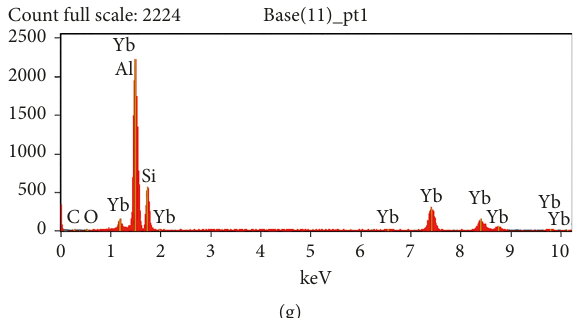
Figure 8: SEM-EDS image of Yb-rich intermetallic compounds in Al-7 wt.% Si alloy with 0.05 wt.% Sr and 0.7 wt.% Yb. (a) SEM image of Yb-rich intermetallic compound; (b) Al, (c) Si, (d) Fe, (e) Yb, (f) Sr, and (g) EDS spectrum obtained from the Al-Si-Yb intermetallic compounds in Al-7 wt.% Si alloy with 0.05 wt.% Sr and 0.7 wt.% Yb. Table 4: Enthalpies of formation of Al-(Si)-RE compounds ( T 0K). (cid:31) Formation enthalpy Intermetallic compounds